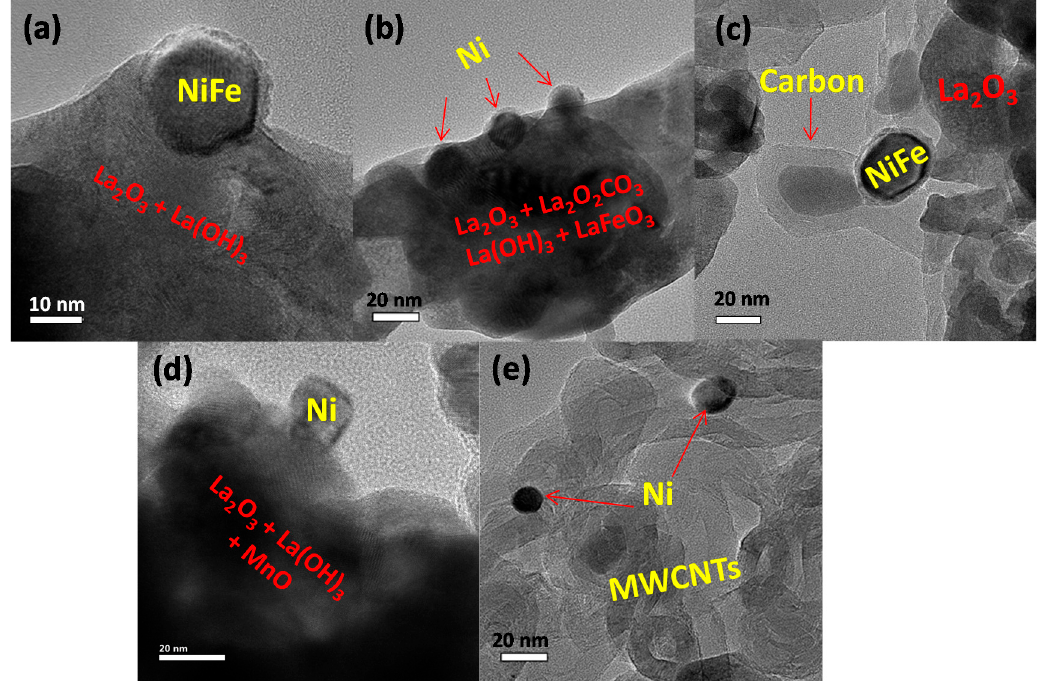
Figure 7. TEM images of the LaNi 0.8 Fe 0.2 O 3 perovskite ( a ) reduced, shows the exsolved Ni-Fe alloy from the perovskite; after dry reforming of methane (DRM) at 800 °C for ( b ) 12 h exsolved Ni particles are well socketed to the support after DRM and shows no carbon accumulation of spent catalyst, and ( c ) 34 h shows slight carbon accumulation of spent catalyst; high-resolution TEM images of LaNi 0.8 Mn 0.2 O 3 ( d ) reduced shows poor interaction of exsolved Ni crystal from the perovskite (new image added) ( e ) after DRM at 800 ◦ C for 34 h shows the Ni particles surrounded by multi-wall carbon nanotubes